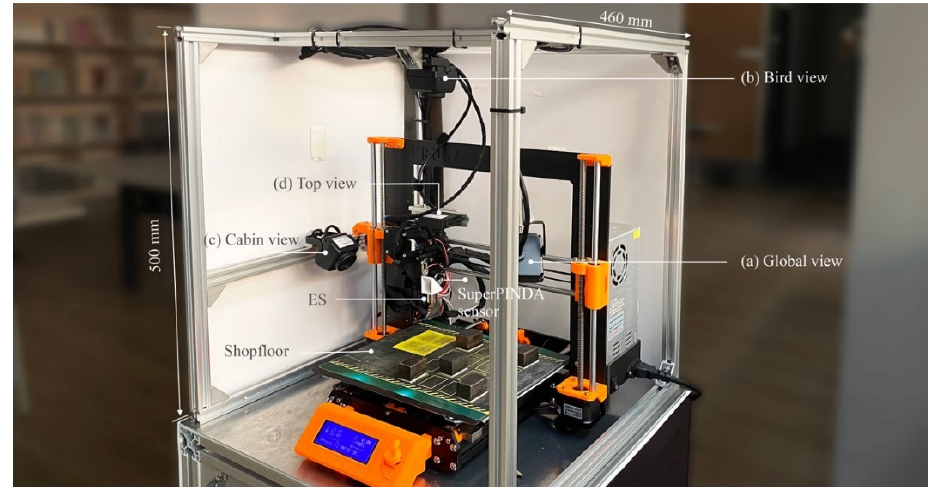
Figure 3. The mechanical prototype of the tele-operated EOT crane.